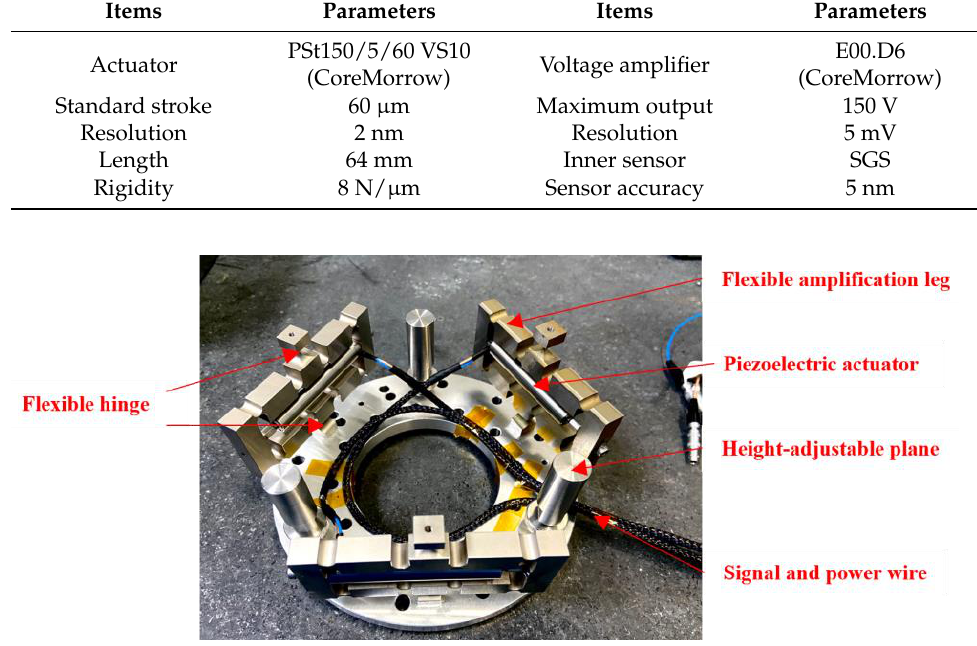
Figure 4. Three actuators assembled on the base platform.